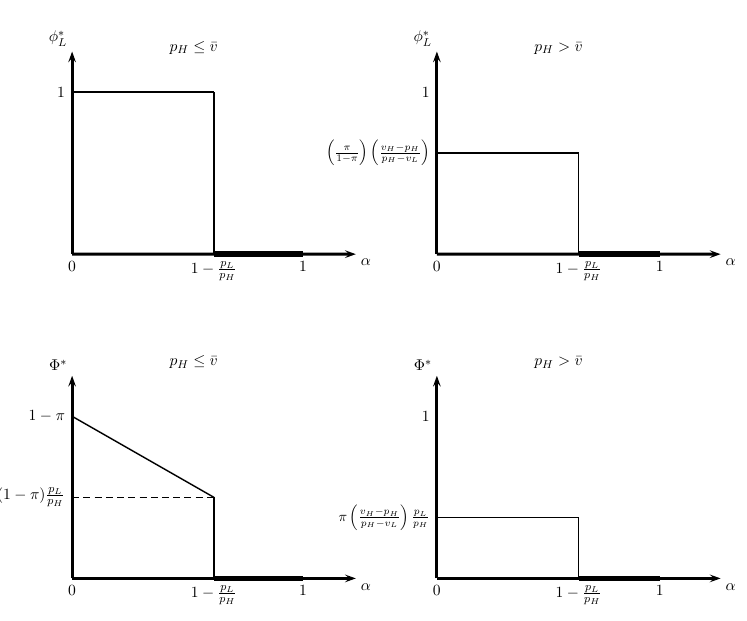
Figure 4. The equilibrium level of fraud and incidence of fraud as a function of the fraction of informed consumers α